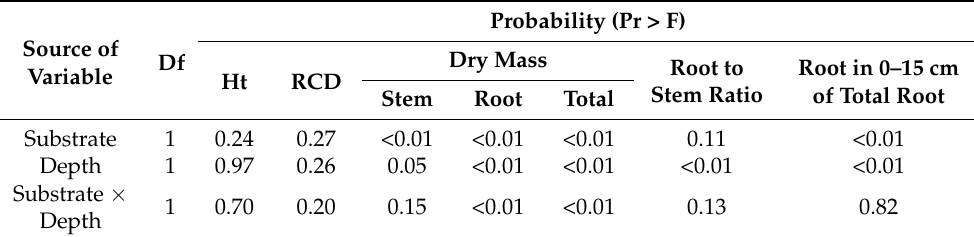
Figure 2. ( a , c ) Height and root collar diameter growth of Populus sibirica seedlings in 30 and 60 cm containers and in ( b , d ) homogenous and heterogeneous substrates. Vertical bars show standard errors. Table 2. The p-values of two-way ANOVA ( α = 0.05) for growth parameters of Populus sibirica in response to substrate and container